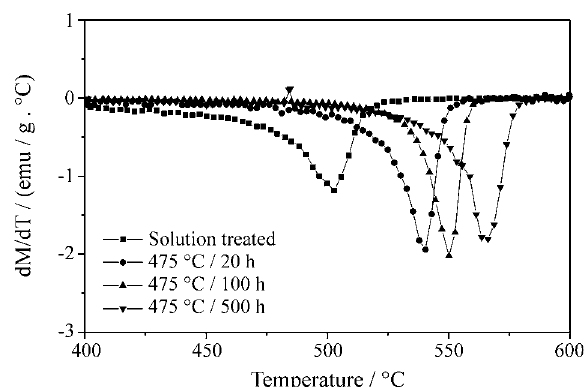
Figure 5. Curie Temperature (T c )